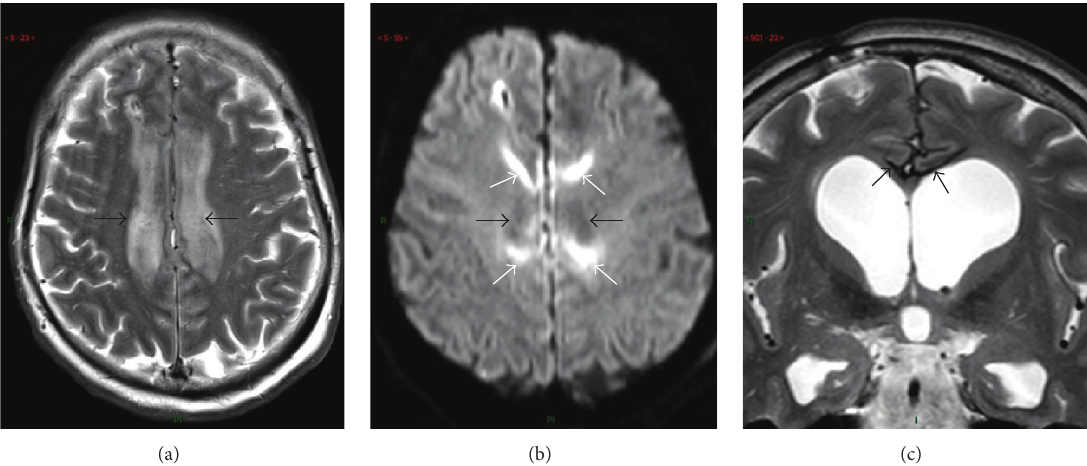
Figure 2: MRI work-up (a-b) at acute phase and delayed (7 months) MRI follow-up examination (c) of patient 1. (a) Axial transverse T2- weighted fast-spin echo (FSE) view through cingulate gyri demonstrating similar findings as in previous patient: oedema-related strong hypersignal intensity within them on both sides (black arrows). (b) Axial transverse diffusion-weighted ( 𝑏 factor = 1000 s/mm 2 ) view in similar slice location (black arrows) failed to reveal hypersignal intensity, thereby excluding ischaemic cytotoxic damage. Only false positive artifacts due to adjacent hematoma were seen (white arrows). (c) Coronal T2-weighted FSE MR view at chronic phase (7 months) showed intrinsic textural integrity of the cingulate gyri. Meningeal hemosiderosis surrounding cingulate gyri featured by pial strong hyposignal intensity was present